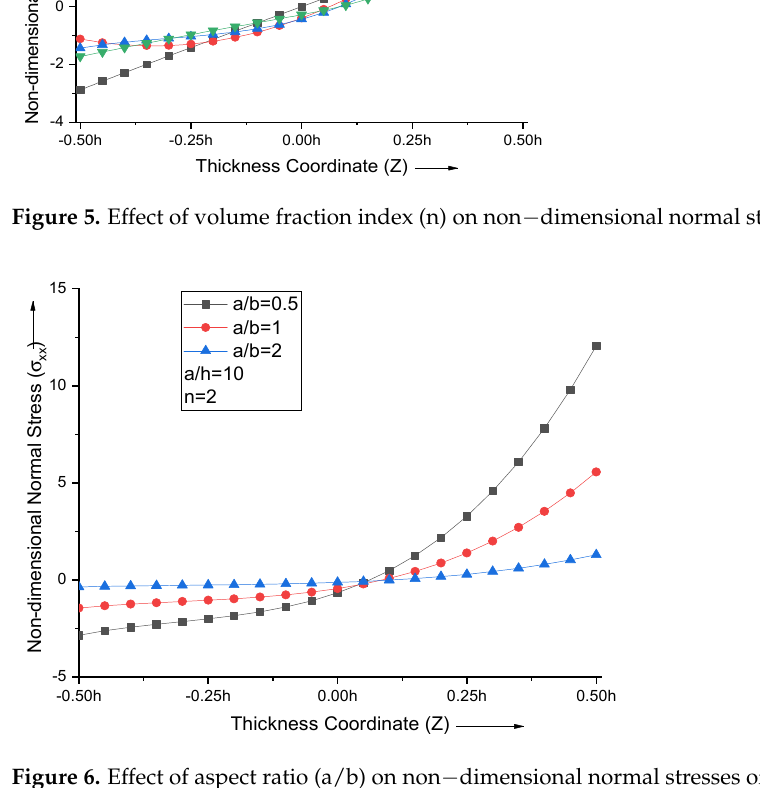
Figure 6. Effect of aspect ratio (a/b) on non − dimensional normal stresses of the plate. The increase in the side-to-thickness ratio (a/h) leads to an increase in the maximum normal stress value. For all the values of the side-to-thickness ratio with n = 2, non-dimen- sional normal stress curves attain zero at Z = 0.075, as shown in Figure 7.